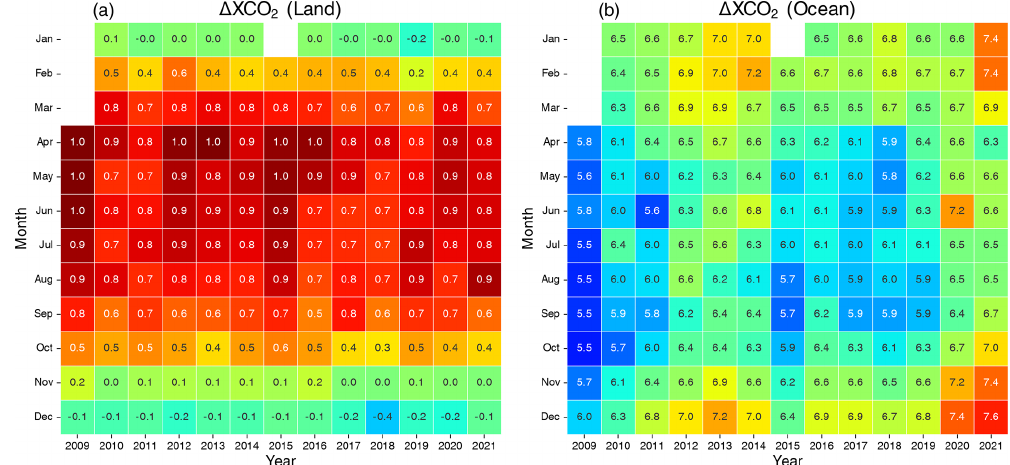
Figure 16. Time series heat maps of the monthly mean changes of XCO 2 by the bias correction over land (a) and the ocean (b) . The color scales differ for the